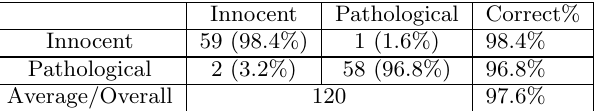
Table 2: Classification result of heart murmurs in